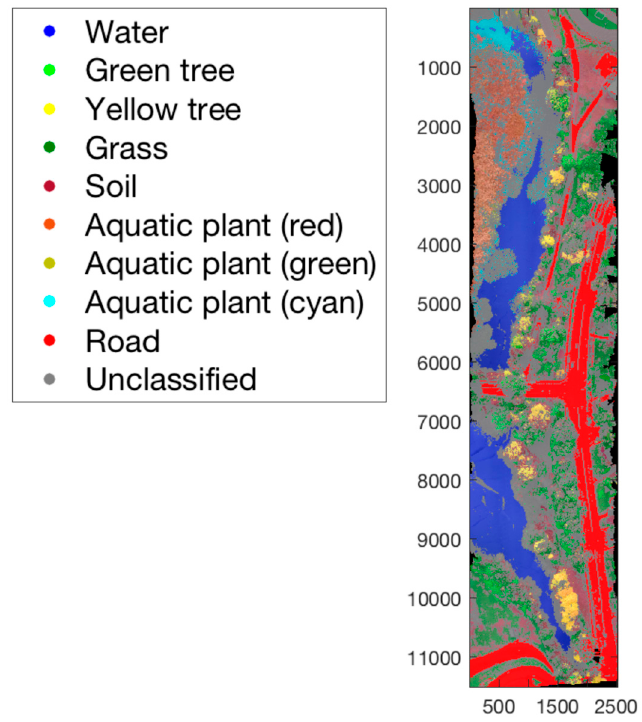
Figure 9. Rule-based classification of the RGB orthomosaic. The coordinate axes are number of the pixels.